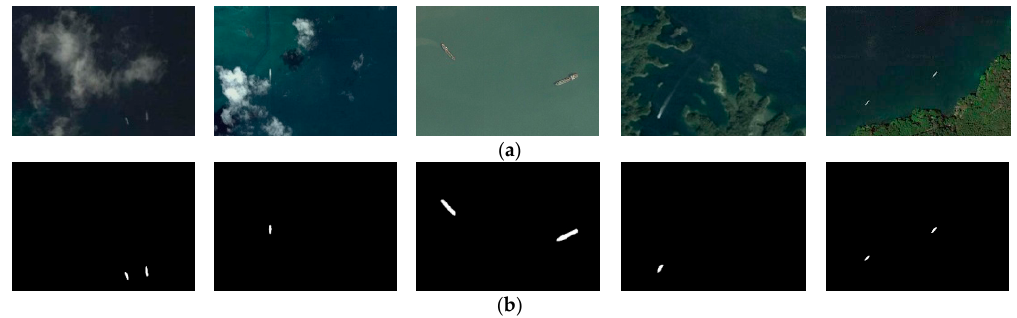
Figure 13. Some input images and the corresponding ground-truth maps: ( a ) input images; and ( b ) ground-truth maps.